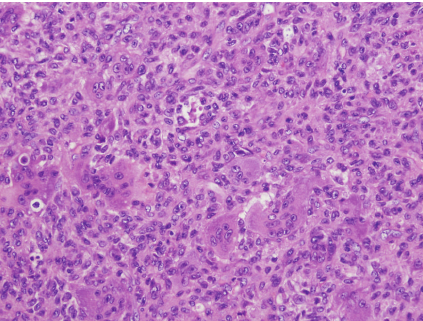
Figure 1: Histology of hemipelvectomy specimen showed mononu- clear cells with interspersed multinucleated cells (hematoxylin and eosin stain, 20x).